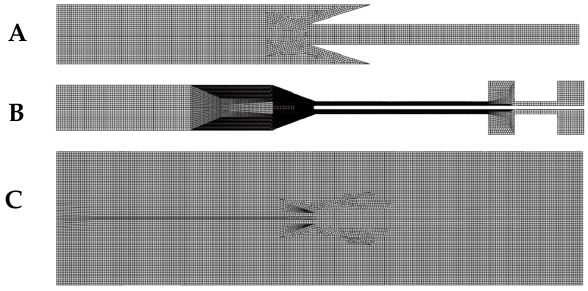
Figure 5. The meshing system for ( A ) the encapsulation layer, ( B ) the conductive path, and ( C ) the substrate.